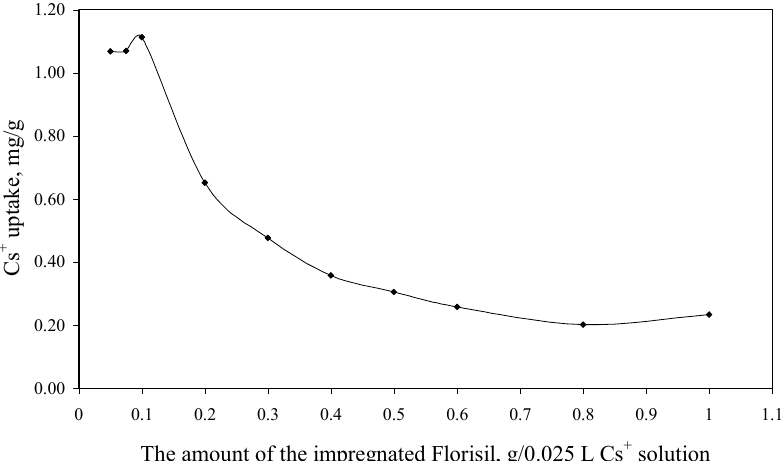
= 10 mg/L, V = 25 mL, t = 2 h, pH = Florisil ® (C i